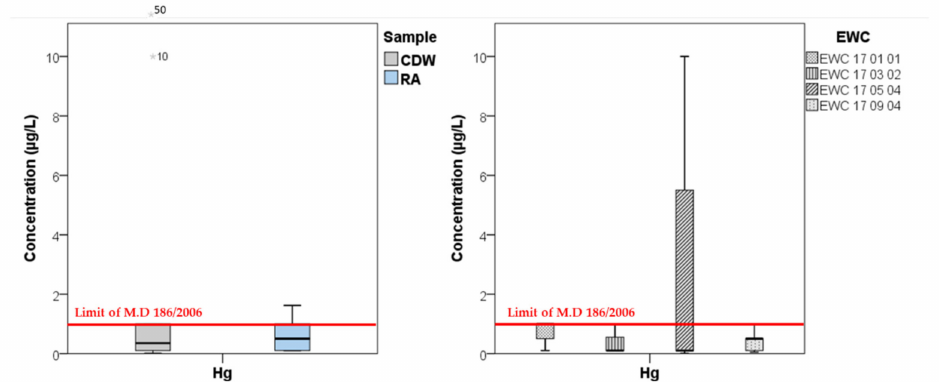
Figure 7. Mercury release in CDWs and RAs ( left ) and EWC code responsible for the highest release ( right ).